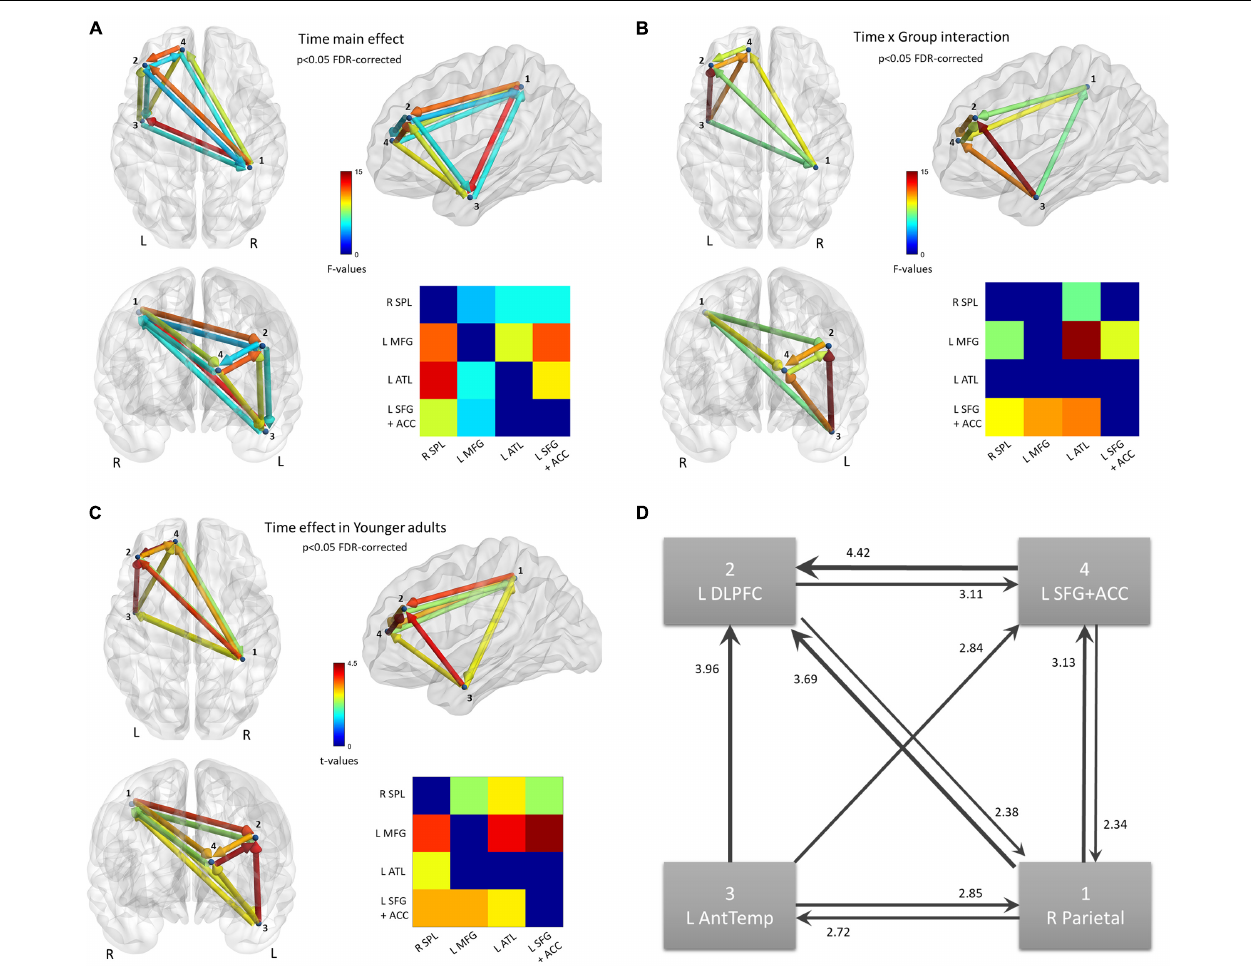
FIGURE 5 | Functional connectivity results. Nodes of the network were defined based on the findings of the source activation analysis in the Auditory strand of analysis. Flow of information is measured by Transfer Entropy. (A) Network that increases Transfer Entropy after training, for all subjects; p < 0.05 FDR-corrected. (B) Network connections that show a statistically significant Time × Group interaction; p < 0.05 FDR-corrected. (C) Time effect on the network, revealed from the new model that includes only the Young group; p < 0.05 FDR-corrected. (D) Schematic of the Time effect in (C) . Edges are weighted by t -values, also shown as